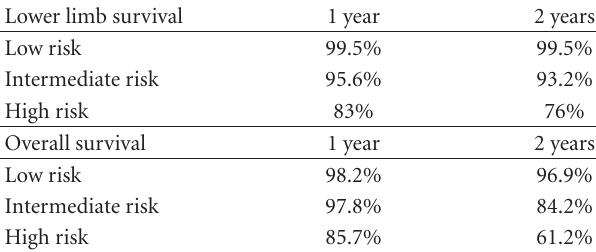
Table 4: Two-year outcomes of lower limb survival and overall survival by risk classification. Lower limb and overall survival were significantly lower in the high-risk group compared to those in the other